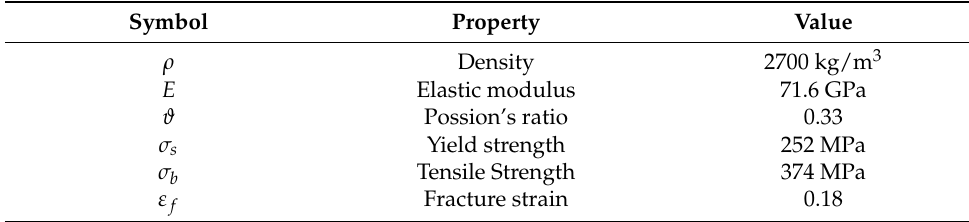
Table 1. Material properties of 6061-T6 aluminum alloy.